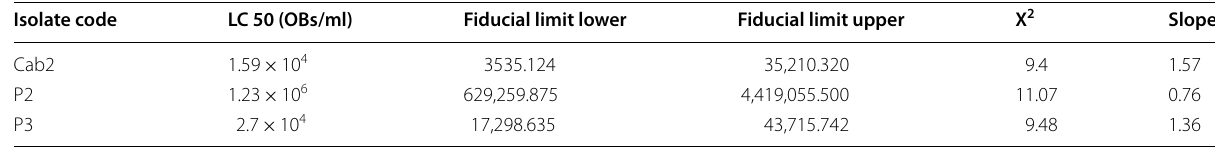
Table 1 Bioassay of Spodoptera littoralis nucleopolyhedrovirus against the first instar S. littoralis larvae Isolate code